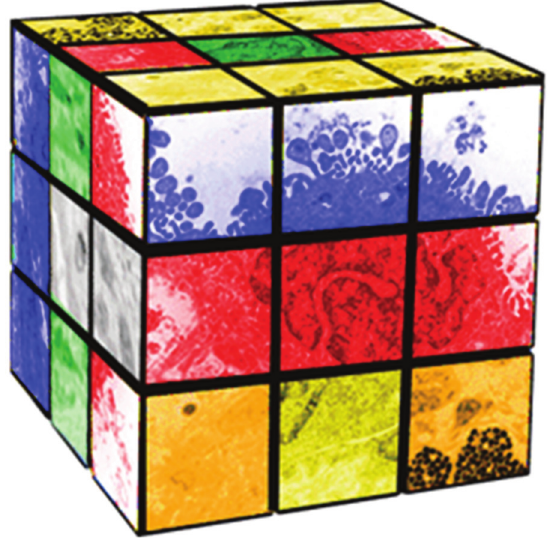
Figure 1. Pleiotropy as a Rubik